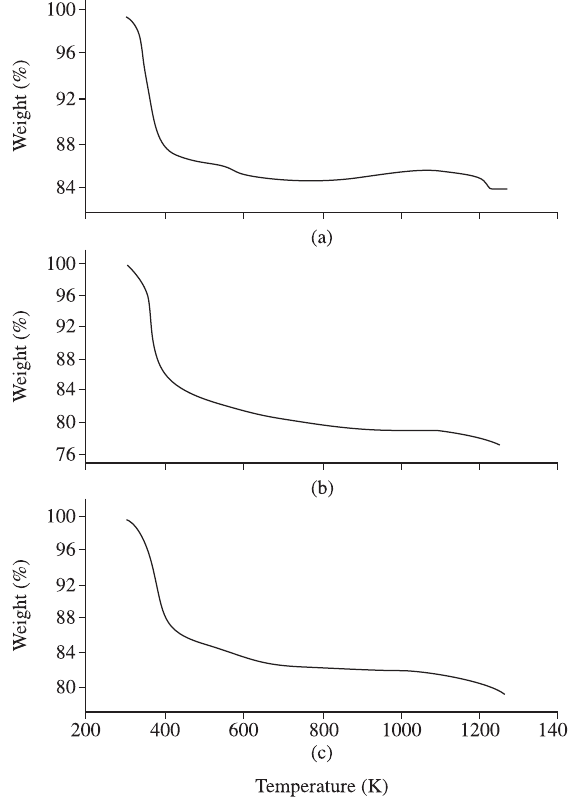
Figure 9. Thermo gravimetric analysis for (A) Ni (C) Zn